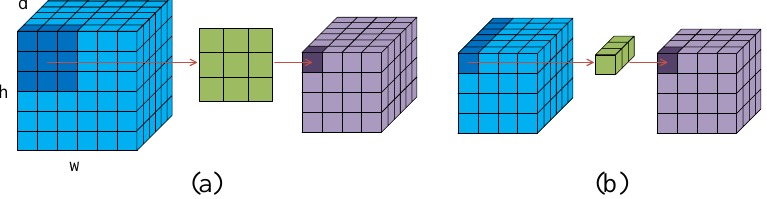
Figure 3. The process of pseudo-3D convolution (P3D). P3D is divided into two steps to achieve low-latency approximation to C3D, and a nonlinear activation exists between the two. ( a ) Step 1: Operating 2D convolution in the spatial dimension of the h × w × d input, each kernel is k × k × 1 and the corresponding output is a ( h − k + 1 ) × ( w − k + 1 ) × d cube. ( b ) Step 2: Operating 1D convolution in the depth dimension, each kernel is 1 × 1 × k . Getting the final output with the size